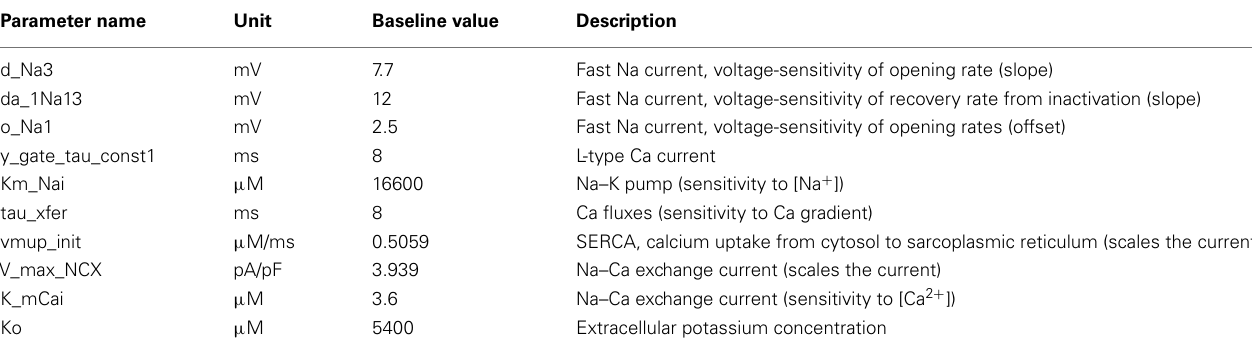
FIGURE 4 | Elasticities and sensitivities of phenotypes (columns) with respect to parameters (rows) for selected components and phenotypes. The body of the table shows the change in phenotype per change in parameter (red = positive, blue = negative), expressed as percent (for ratio–scale quantities) or millivolt (for base and peak voltage, and voltage